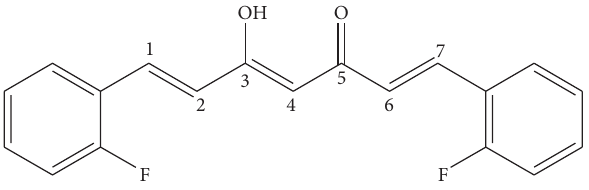
Figure 2: Structure of representative compound 1